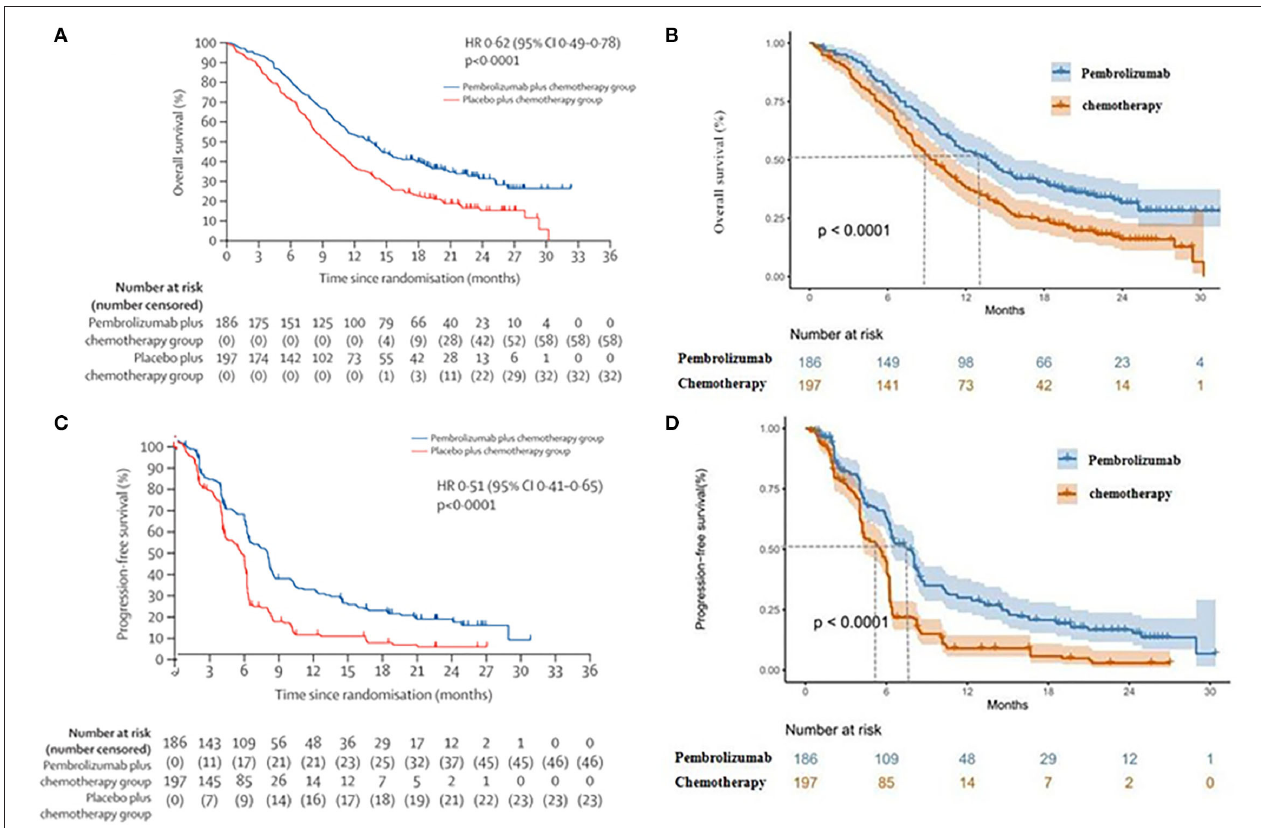
FIGURE 2 | (A) Kaplan–Meier curve of the overall survival from the KEYNOTE-590 trial. (B) Simulate overall survival curve for pembrolizumab group and chemotherapy group. (C) Kaplan–Meier curve of progression-free survival from the KEYNOTE-590 trial. (D) Simulate progression-free survival curve for pembrolizumab group and chemotherapy